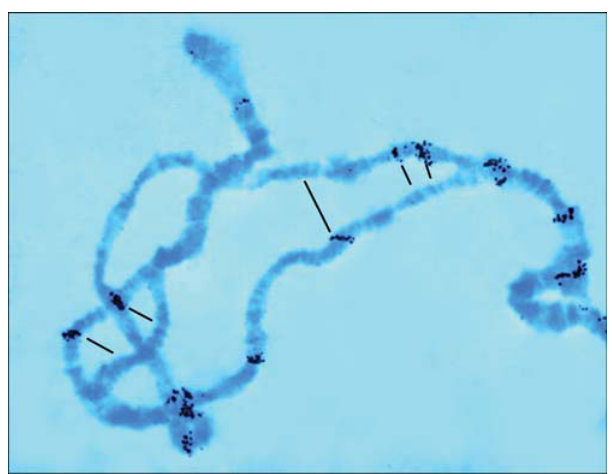
Figure 1. Differential hybridization of a mobile genetic element with asynaptic regions of Drosophila polytene Chromosome